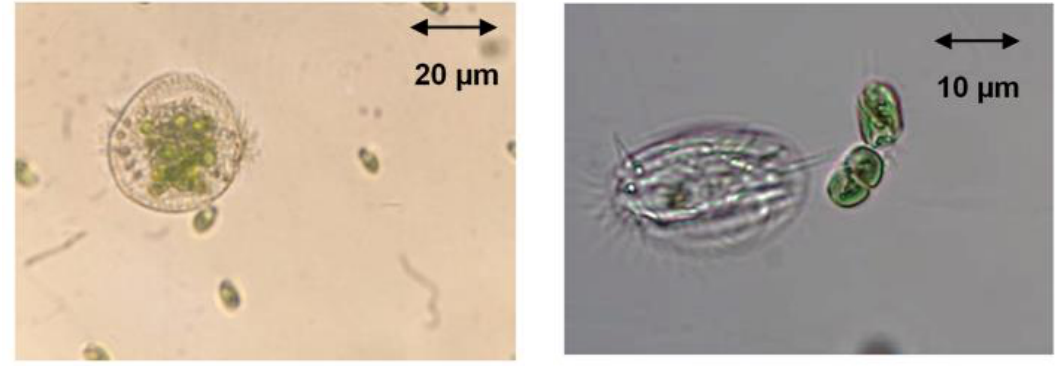
Figure 2. Predators (ciliates) observed in a control Tetraselmis culture in seawater